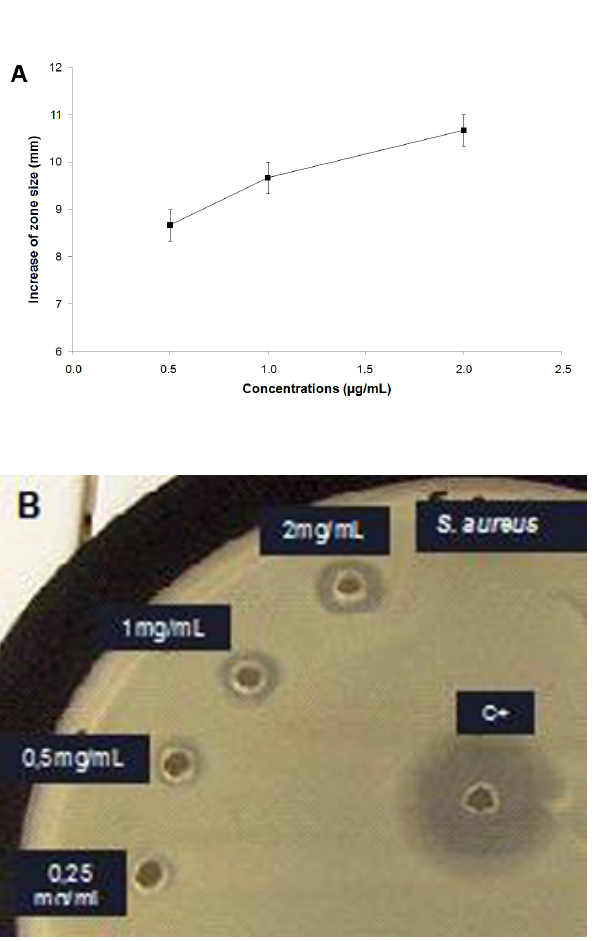
Figure 2. Antibacterial activity of BleuTV in a disk- diffusion assay. ( A , B ) Antibacterial activity of BleuTV against S. aureus ( ■ ). The values represent the mean ± SEM of three independent assays performed in triplicate. The inhibition zone is given in mm, including the 5 mm diameter of the well, after 18 hours of incubation. BleuTV: whole venom of B. leucurus . C – :